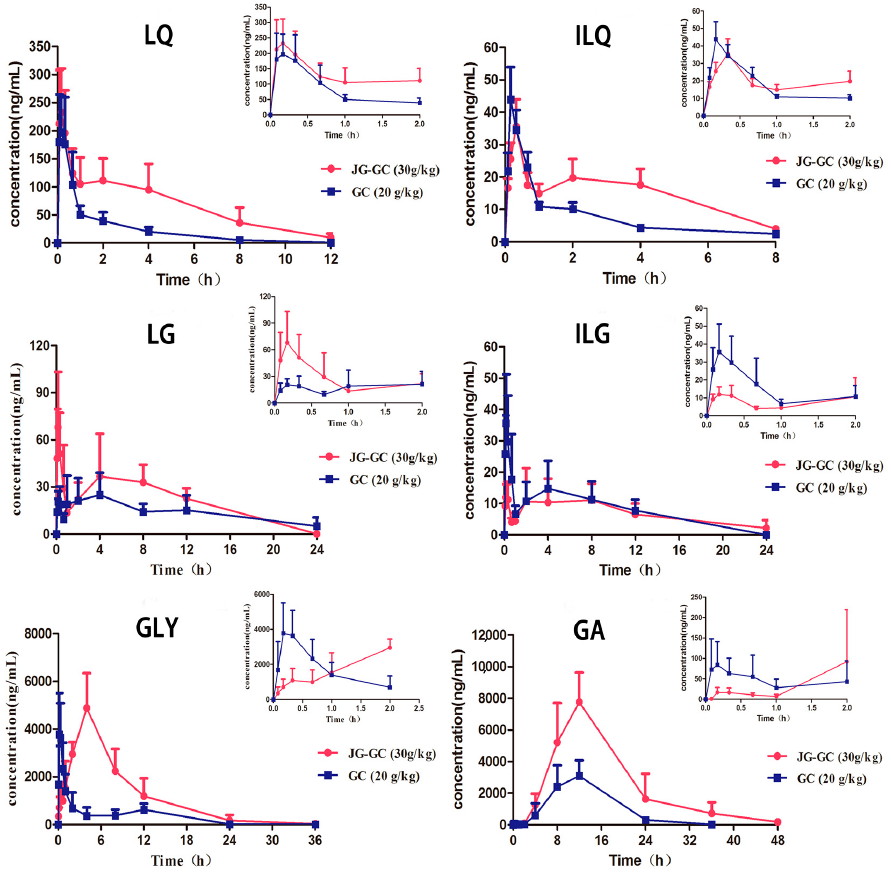
Figure 2. Time–concentration profiles of LQ, ILQ, LG, ILG, GLY and GA in rat plasma from Group 1 ( ): JG–GC (30 g/kg, p.o.); Group 2 ( ): GC (20 g/kg, p.o.). The upper right corner of each drug curve shows the corresponding drug profile within 2 h.